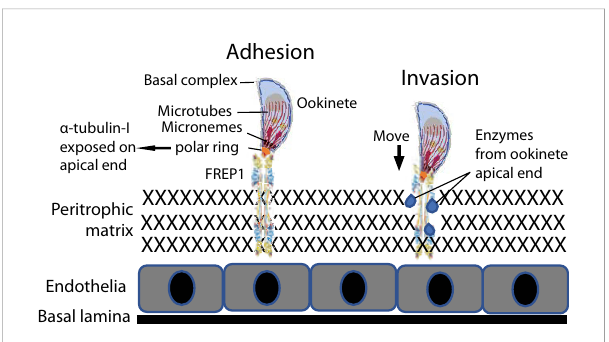
FIGURE 10 Model of the FREP1- a -tubulin-1 interaction that mediates Plasmodium infection of the mosquito midgut. Adhesion) The interaction between FREP1 in the peritrophic matrix (PM) and parasite a -tubulin-1 exposed on the cell surface at ookinete apical ends orientates invasive apparatus opening toward the PM. Invasion) Enzymes released from the parasitic apical opening disrupt midgut integrity. Together, these actions facilitate an ookinete to penetrate the midgut physical barrier for